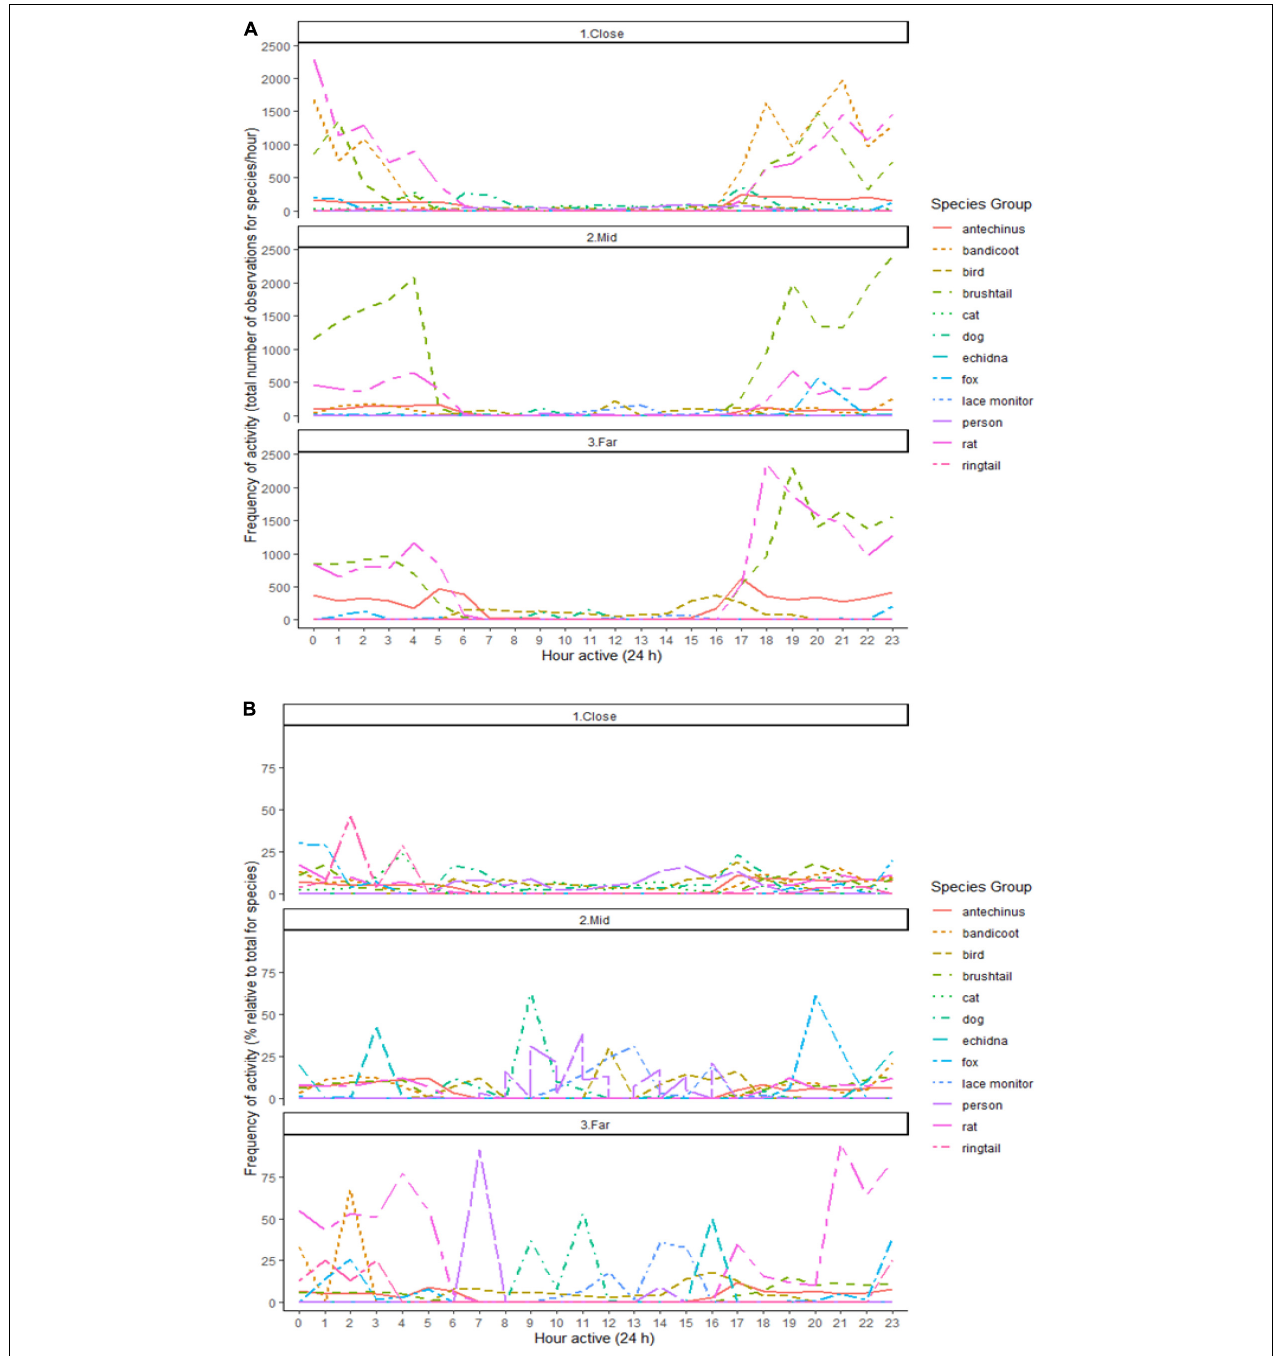
FIGURE 5 | The frequency of activity across 24 h by the (A) total number of observations, and (B) percentage relative to the total number of observations, for each observed species (brown antechinus, northern brown bandicoot, birds, common brushtail possum, domestic cat, pet dogs, short-beaked echidna, red fox, lace monitor, person, brown and black rats combined, common ringtail possum) along an urban disturbance gradient with three environments (close, mid, and far), under the combined treatment conditions, at both giving-up density stations and baited predator